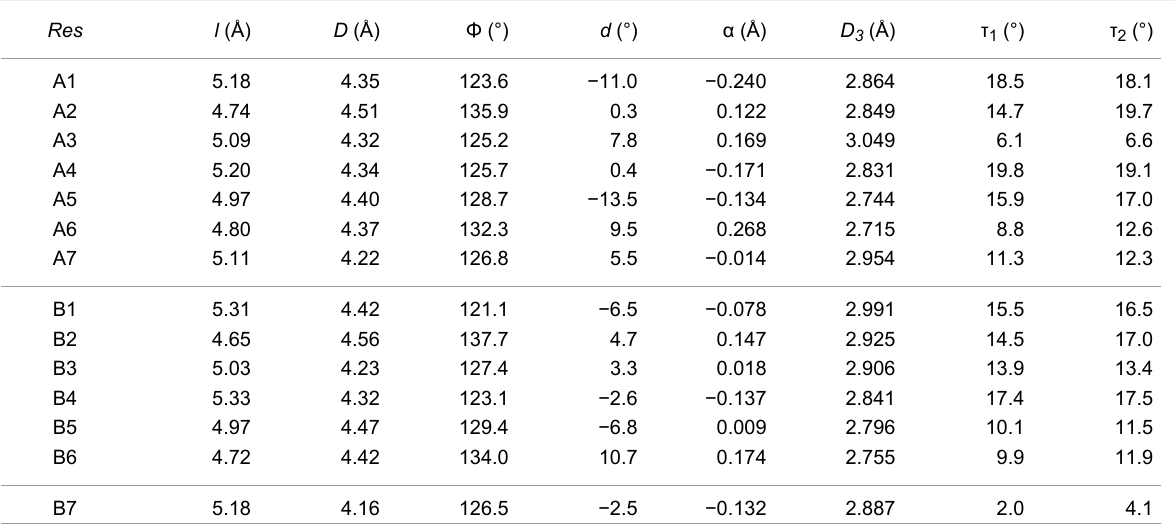
Table 3: Conformational parameters of the host molecules. a